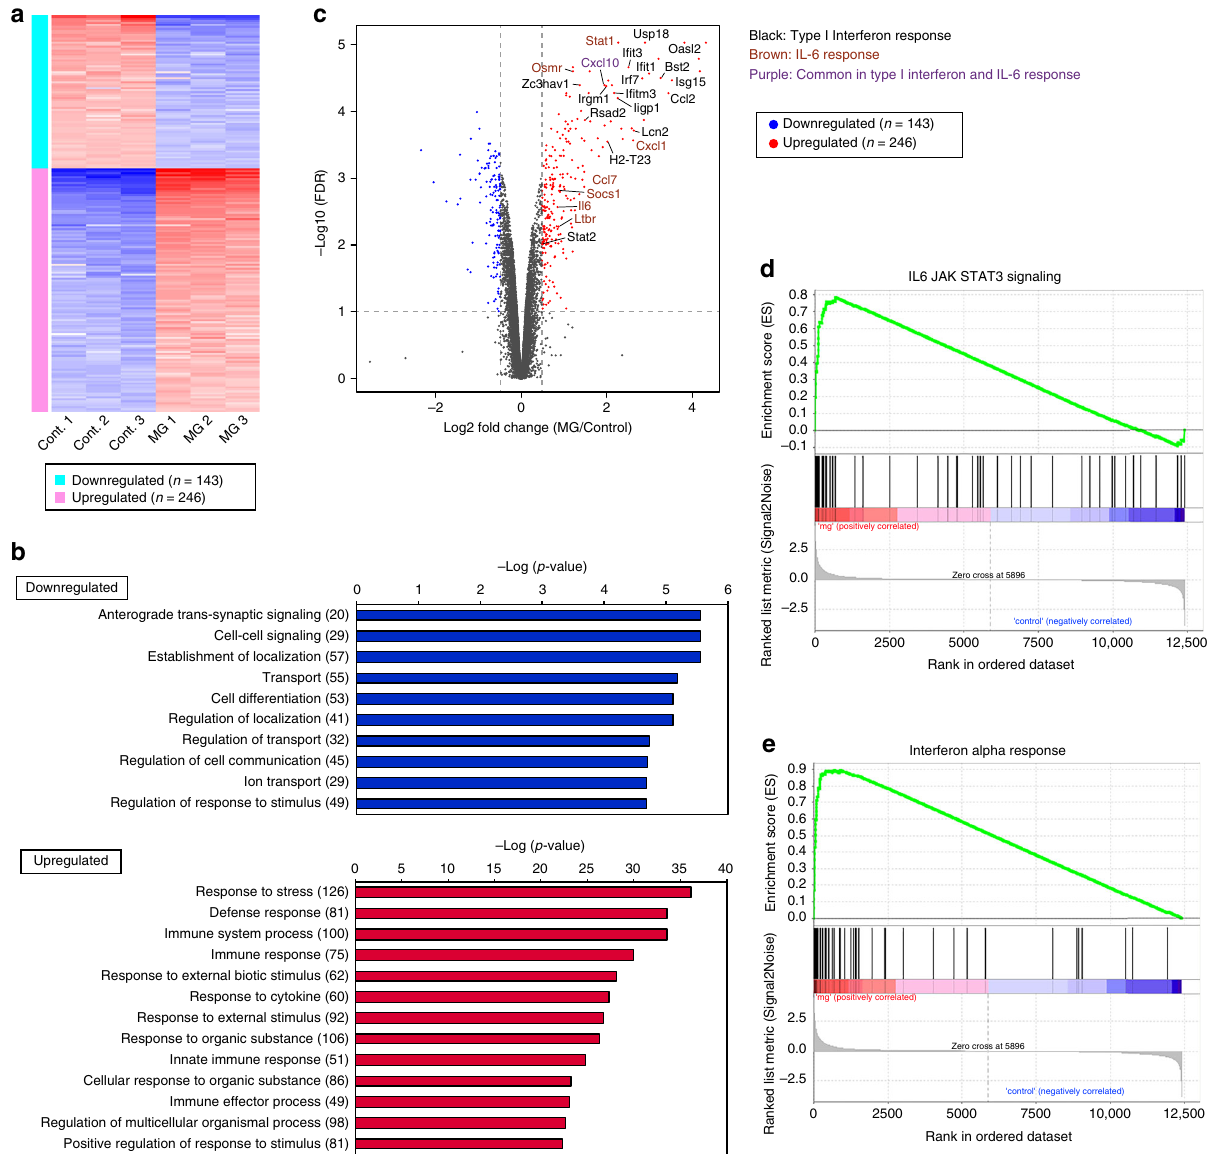
Fig. 8 Signaling pathways triggered by IL-6 and IFN-I were activated in CP-like neurons after coculture with microglia. a Transcriptomic pro fi les of the neurons Cont and neurons MG groups based on differentially expressed gene (DEG) analysis. Among the genes that were reliably detected in both groups (11,603 genes), we identi fi ed 143 downregulated genes and 246 upregulated genes in neurons MG group based on the statistical threshold (log 2 fold change [FC] > 1.4, FDR < 0.1). b Gene ontology (GO) analysis for signi fi cantly downregulated and upregulated genes (see Supplementary Table 3). c A volcano plot depicting DEGs between the neurons Cont and neurons MG groups. The negative log of FDR is plotted on the Y -axis, and the log 2 FC of neurons MG / neurons Cont is plotted on the X -axis. The blue and red points on this graph represent mRNAs that were signi fi cantly downregulated ( n = 143) and upregulated ( n = 246), respectively, in neurons MG (FC > 1.4; FDR < 0.1). The color of the gene names indicates that the genes are typical in the type I interferon response (black), typical in the IL-6 response (brown), and common in type I interferon and IL-6 responses (purple). Gene set enrichment analysis showing a barcode plot for genes registered in IL-6 JAK STAT3 signaling ( d ) or the interferon alpha response ( e ). Genes were ranked based on their differential expression between neurons MG and neurons Cont . A plot of running enrichment score (RES) is shown in green (top). The vertical black bars (middle) indicate a gene within each gene set. The correlation of the expression pattern of genes belonging to each subcluster is shown in the gray histogram (bottom). The RNA-Seq data are summarized in Supplementary Data